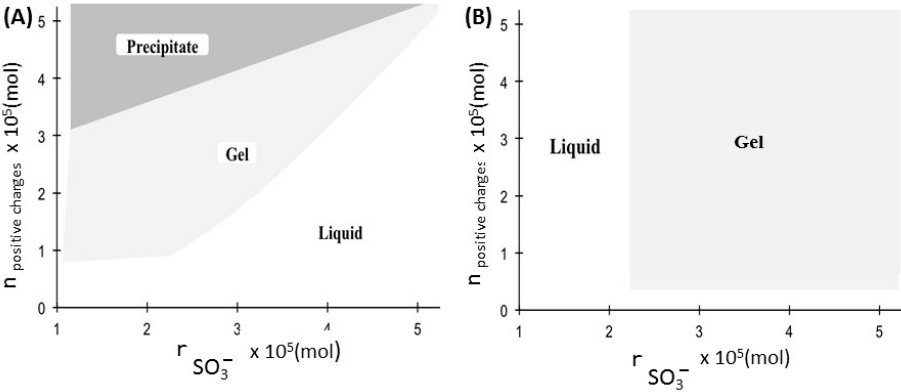
Figure 6. Schematic representation of the effect of the number of positive charges for Ca 2+ ( A ) or TA-N(CH 3 ) 3+ ( B ) as a function of the amount of SO 3- in the gel formation. Table 1. Influence of PHO-SO 3 − concentration on gel mechanical properties of PHOSO 3 − /Ca 2+ net- works at 10 Hz.